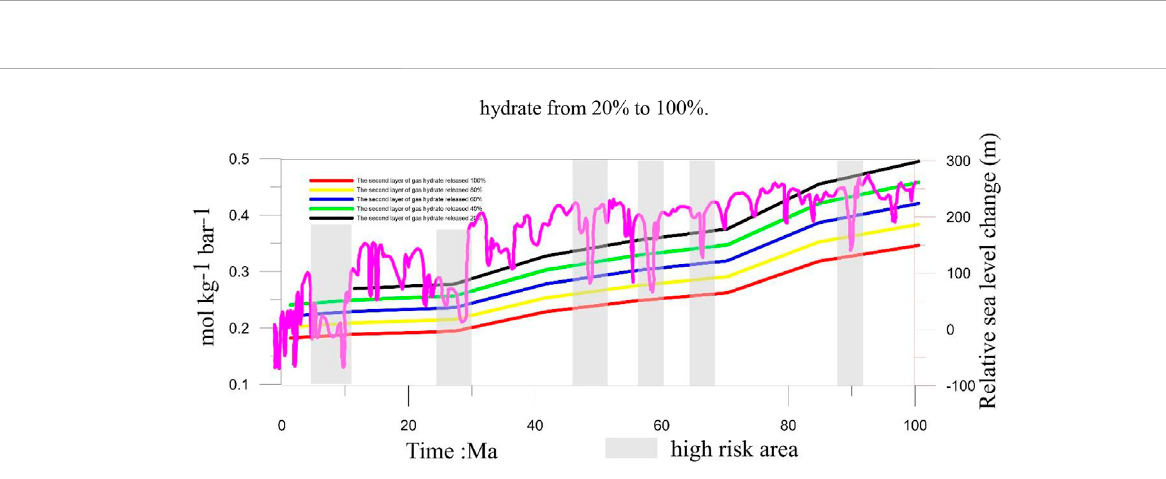
FIGURE 7 Riskrangingfrompresentto100 MaBP.Thepurplecurverepresentsthechangeinglobalsealevel.ThegreyarearepresentsthehighriskofH 2 S going into the